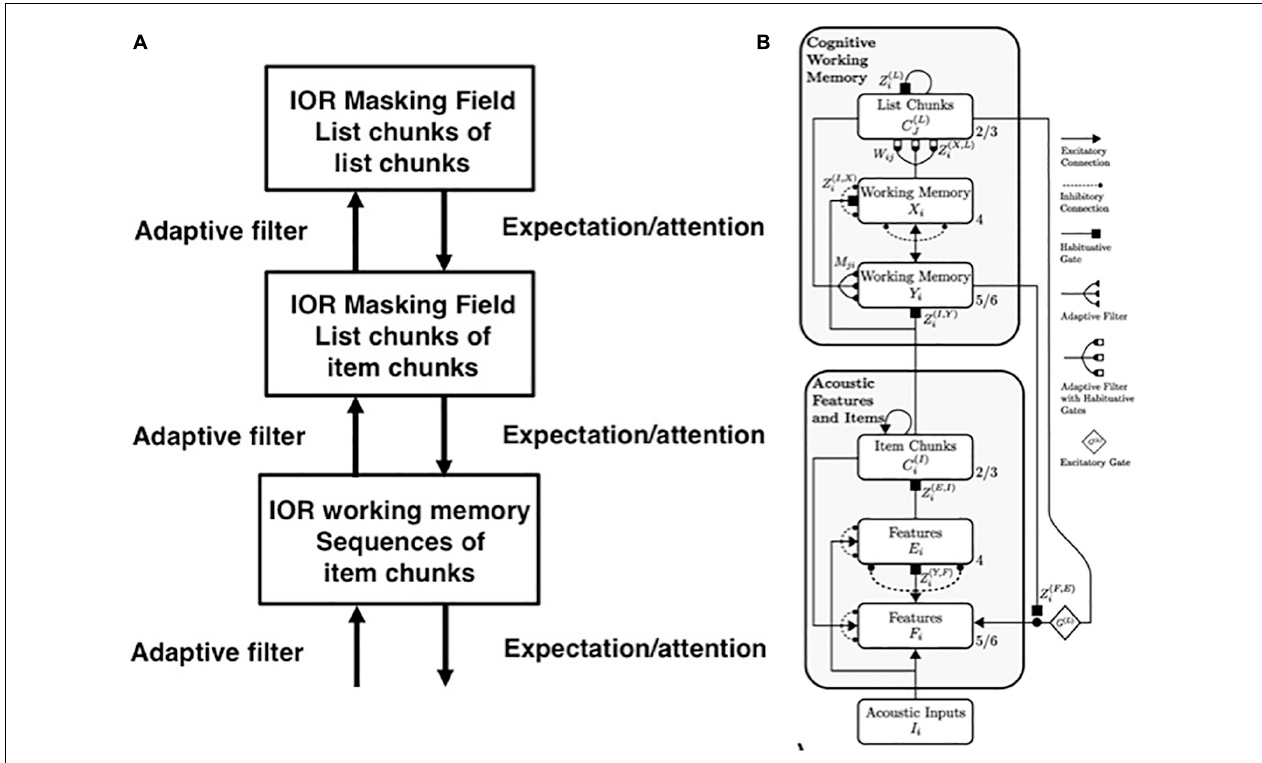
FIGURE 4 | (A) Hierarchy of speech processing levels. Interactions among three speech processing levels are capable of working memory storage, learning, stable memory, and performance of word sequences with repeated words. Each level consists of an Item-Order-Rank working memory. The second and third levels are, in addition, multiple-scale Masking Fields that can store sequences of variable length. All the levels are connected by Adaptive Resonance Theory bottom-up adaptive filters and top-down learned expectations and their attentional focusing and memory stabilization capabilities. The first level stores sequences of item chunks. Its inputs to the second level enable that level to store list chunks of item chunks. The inputs of the second level to the third level enable it to store list chunks of list chunks, in particular sequences of words that may include repeated words. [Reprinted with permission from Grossberg and Kazerounian (2016)]. (B) Macrocircuit of the cARTWORD laminar cortical model for conscious speech perception shows a hierarchy of levels responsible for the processes involved in speech and language perception. Each level is organized into laminar cortical circuits. Deep layers (6 and 4) process and store inputs, whereas superficial layers (2/3) group distributed patterns across the deeper layers into categories, or chunks. The lowest level processes acoustic features (cell activities F i and E i ) and item chunks (cell activities C ( I ) i ), whereas the higher level is responsible for storing of sequences of acoustic items in working memory (activities Y i and X i ), and representing stored sequences of these items as list chunks (activities C ( L ) j ) in a Masking Field. [Reprinted with permission from Grossberg and Kazerounian